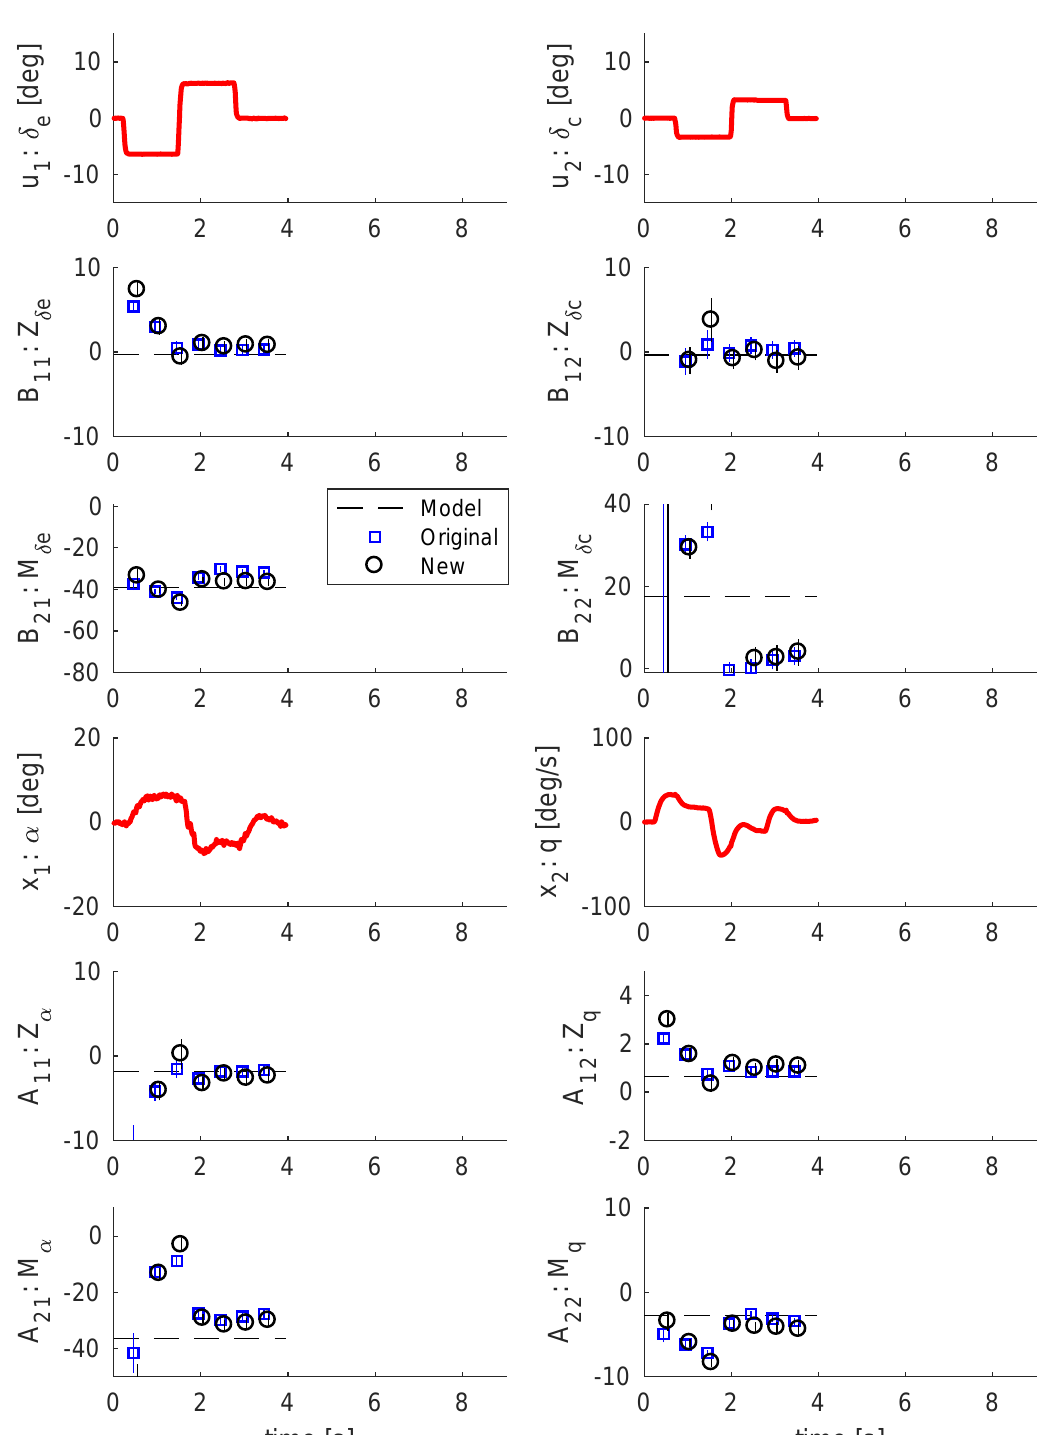
Figure 16. Results from flight FT. #2 with manoeuvre DPp. The flight test data are shown in red, the results from the original method as blue squares and the results from the new method as black circles. The uncertainties are given as vertical bars. Note that the model (17) is not the true